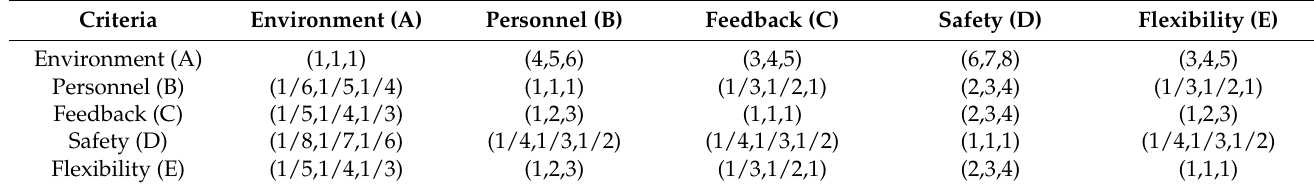
Table 3. The fuzzy pairwise comparison matrix for five main criteria from FANP model.